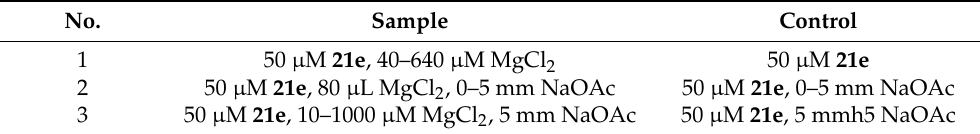
Table 4. Sample and control groups with different components in